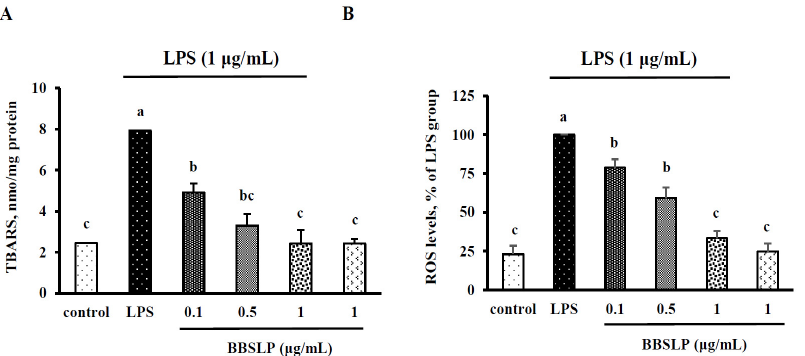
Figure 3. Effects of BBSLP on LPS-induced RAW264.7 cell oxidative stress. RAW264.7 cells (1 × 10 5 cells/30-mm plate) were seeded and cultured overnight, treated with 0.1, 0.5 or 1 μ g/mL BBSLP for 24 h and then induced or not with 1 μ g/mL LPS for another 24 h. The group treated with 1 μ g/mL LPS alone served as an induced control group. BBSLP was diluted in sterilized H 2 O, and cells treated with sterilized H 2 O alone served as the control group. Cells treated with 1 μ g/mL BBSLP